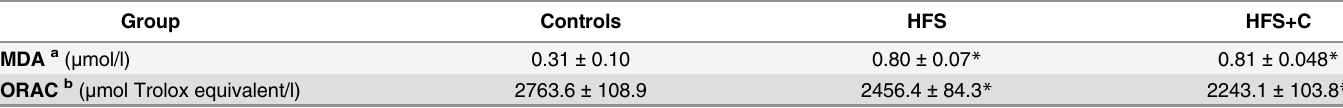
between the controls and the HFS group was fully described in a previous study [22]. Basically, it was observed in the HFS group an increased activity of the delta-9 ( Δ 9D) and delta-6-desaturase ( Δ 6D), and a decrease of the delta-5-desaturase ( Δ 5D), as seen by the 20:4n-6/20:3n-6 ratio, in addition to the depletion of n-6 polyunsaturated fatty acids (n-6 PUFA), 18:2n-6 and its elonga- tion and desaturation product, 20:4n-6. In addition, HFS dietary loading caused a decrease of n-3 PUFA, alpha linolenic acid (18:3n-3, -70%), eicosopentaenoic acid (20:5n-3 or EPA, -33%) and 22:6n-3 (DHA, -33%). The presence of curcuma in the diet did not modify these tendencies. However, the comparison between HFS and HFS+C groups showed a significant decrease of n-3 PUFA, oleic (18:1n-9), myristoleic (14:1) and nervonic acid (24:1n-9) (-75%, -36% and -36%, respectively), associated with a relevant increase of 14:1n-5 and 18:1n-9 acids (more than 2 fold and +22%, respectively).